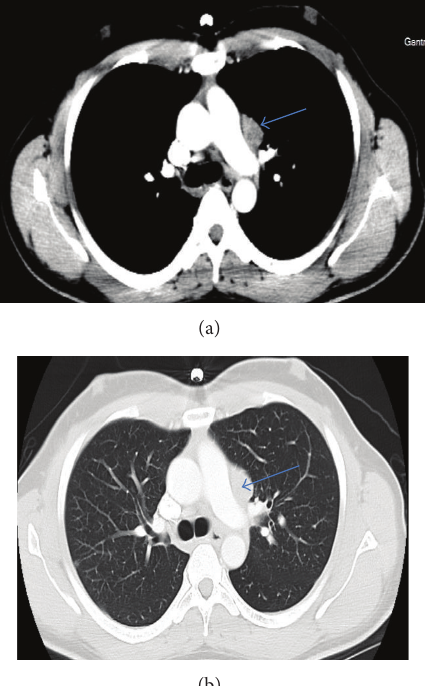
Figure 2: Axial CT scans of the chest ((a) mediastinal window; (b) lung window) showing large mediastinal lymph node with normal lung parenchyma before anti-TB therapy.